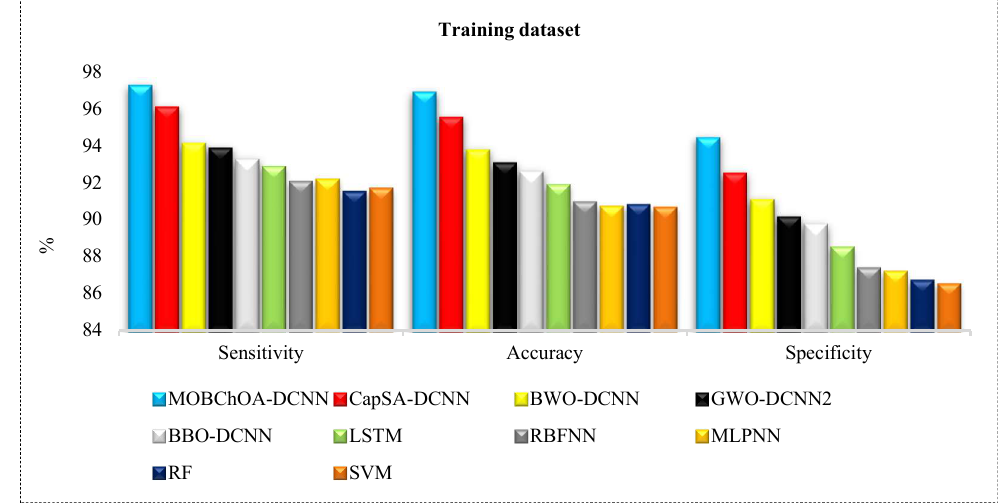
Figure 14. Comparison of architectures in training dataset.